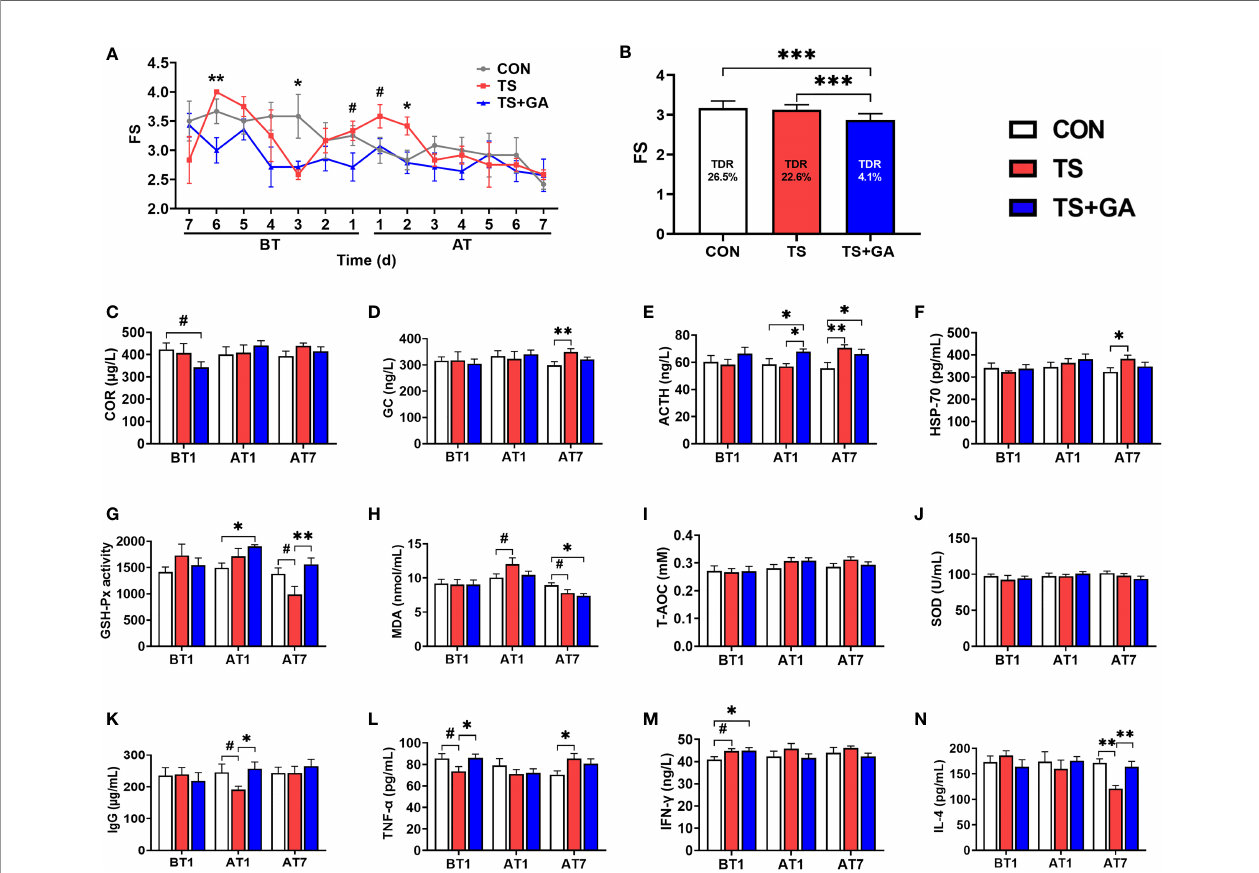
FIGURE 2 | Effect of gallic acid (GA) on fecal score (FS) (A, B) , serum hormone (C – E) , HSP-70 (F) , antioxidant capacity (G – J) , and in fl ammatory factors (K – N) in puppies (n = 6 or 7). The symbol (*) indicates statistically signi fi cant differences between two groups (* p < 0.05, ** p < 0.01, and *** p < 0.001), and the symbol (#) represents difference tendency (# p < 0.10). BT1, the 1st day before transportation; AT1, the 1st day after transportation; AT7, the 7th day after transportation. TDR (total diarrhea rate, %) = [cases of diarrhea during 14 days/(14 days × total puppies for each group)] × 100. COR, cortisol; ACTH, adrenocorticotropic hormone; GC, glucocorticoid; HSP-70, heat stress protein 70; GSH-Px, glutathione peroxidase; MDA, malondialdehyde; T-AOC, total antioxidant capacity; SOD, superoxide dismutase; IgG, immunoglobulin G; TNF- a , tumor necrosis factor- a ; IFN- g , interferon- g ; IL-4, interleukin